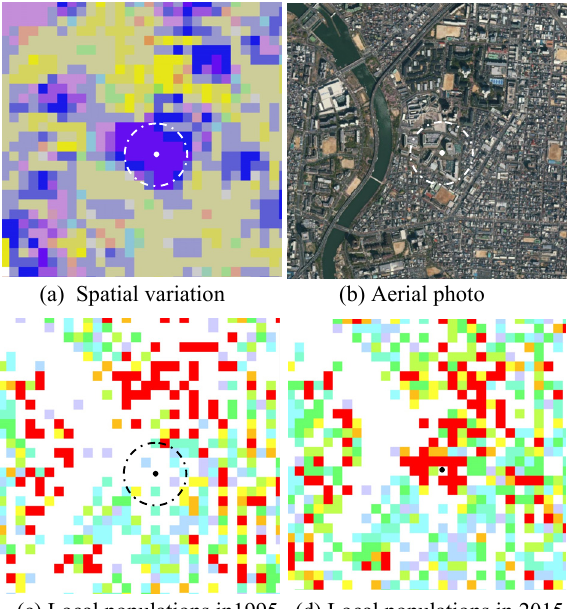
Figure 11 . Partial image of site C in Figure 10 along with aerial photograph and local population distributions. Dashed circle denotes ASP (= 210 m) in 1995. In 2015, circle does not appear (ASP 0 ).